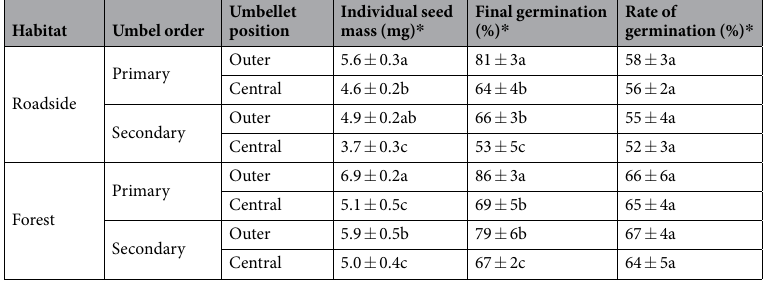
Table 4. Seed mass, germination percentages and rate of germination (Timson’s Index) of seeds from differed umbel (primary and secondary) and umbellet position (outer and central). Germination data (mean ± SD) are from laboratory trials at 22 °C/10 °C with 14/10 h light treatment. * The values followed by the same letter within a column do not differ significantly by ANOVA followed by Tukey’s test at p < 0.05 in the same habitat.